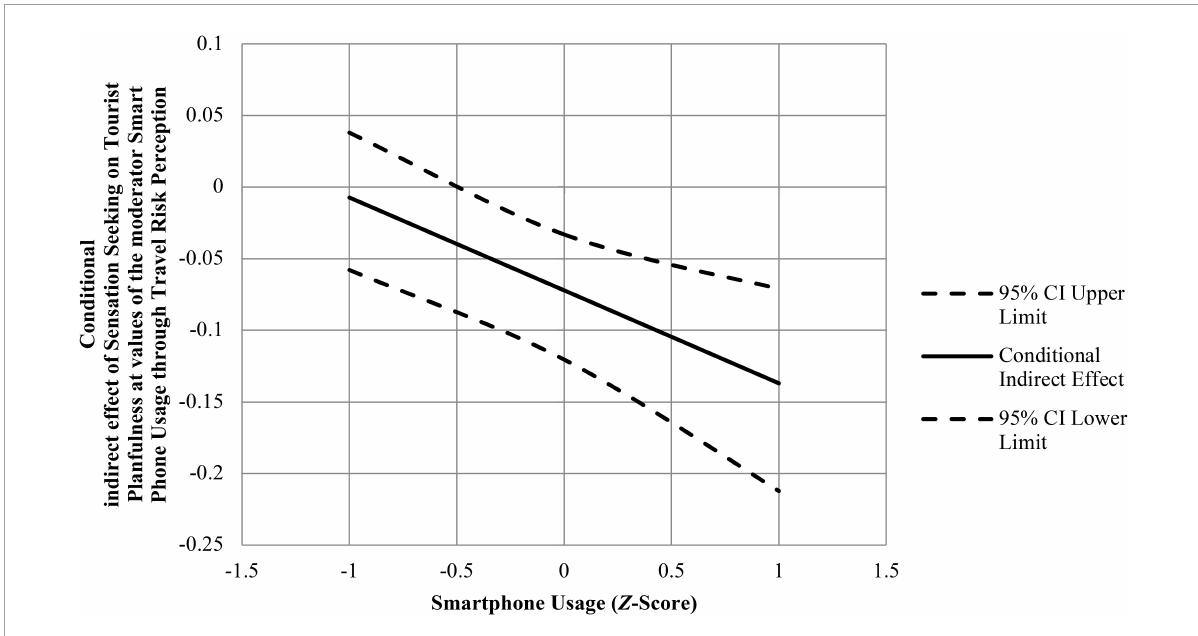
FIGURE3 Graphing of the conditional indirect effect of sensation seeking on tourist planfulness at values of the moderator smartphone usage through travel risk